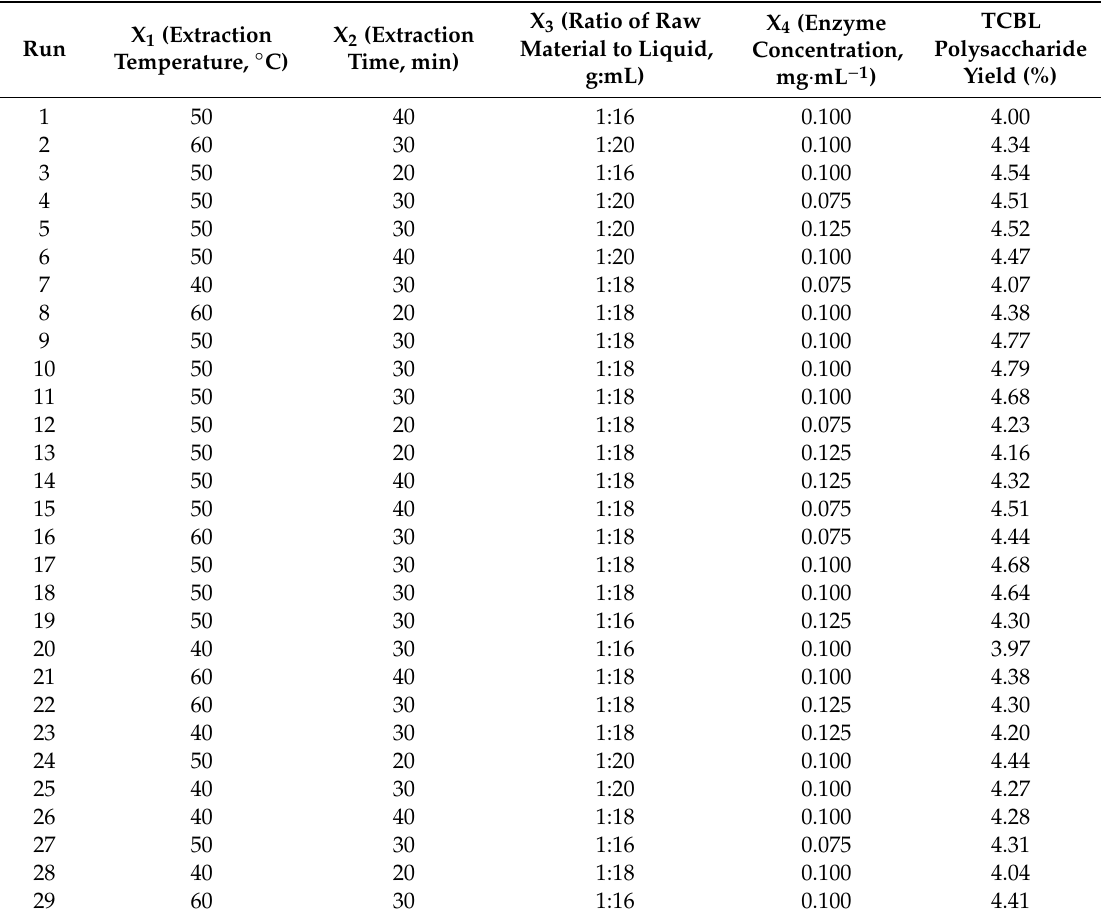
Table 2. Response–surface methodology experimental design and results of TCBL polysaccharide extraction technology by enzyme and ultrasound-assisted coupled extraction